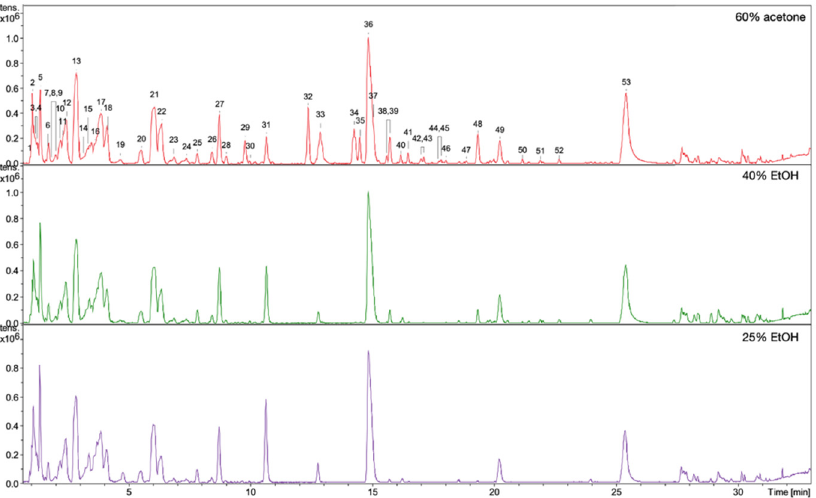
Figure 6. ESI-MS (negative mode) chromatograms of 60% acetone, 40% EtOH, and 25% EtOH extracts from rhizomes of R. japonica . Key to peak identity as in Table 3.